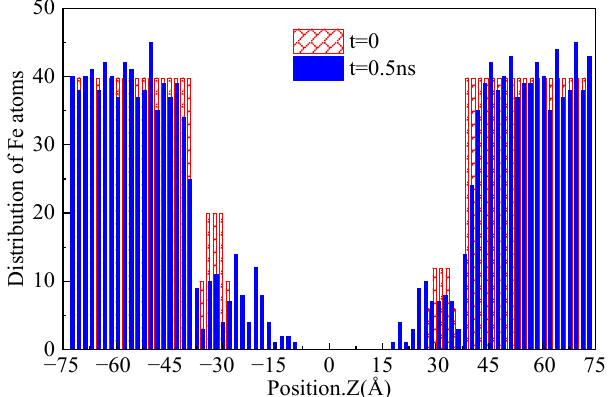
Figure 5. Initial and last distribution of Fe in model B.